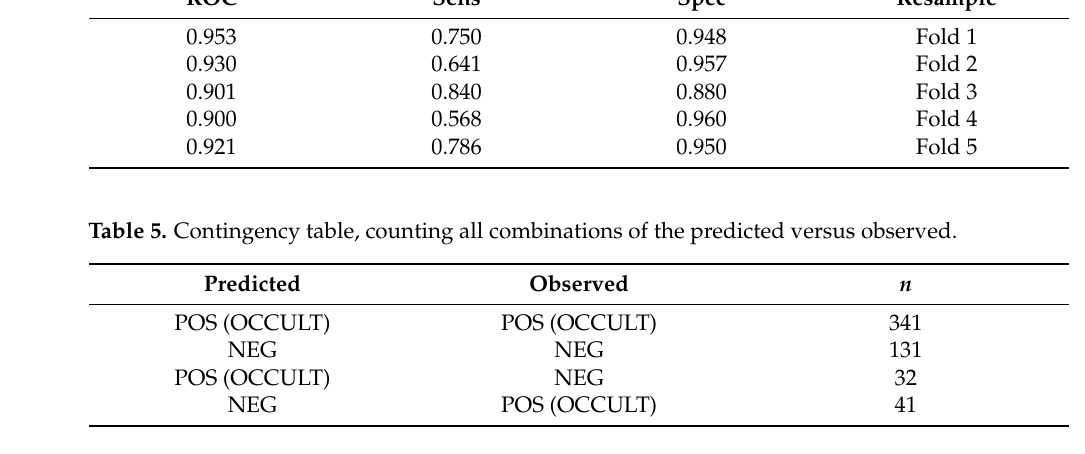
ROC indicates area under the curve in percentage; and resample indicates the specific fold from the five-fold cross-validation. Predicted indicates class predicted by the model; observed indicates class as graded on FA; and n indicates the number of